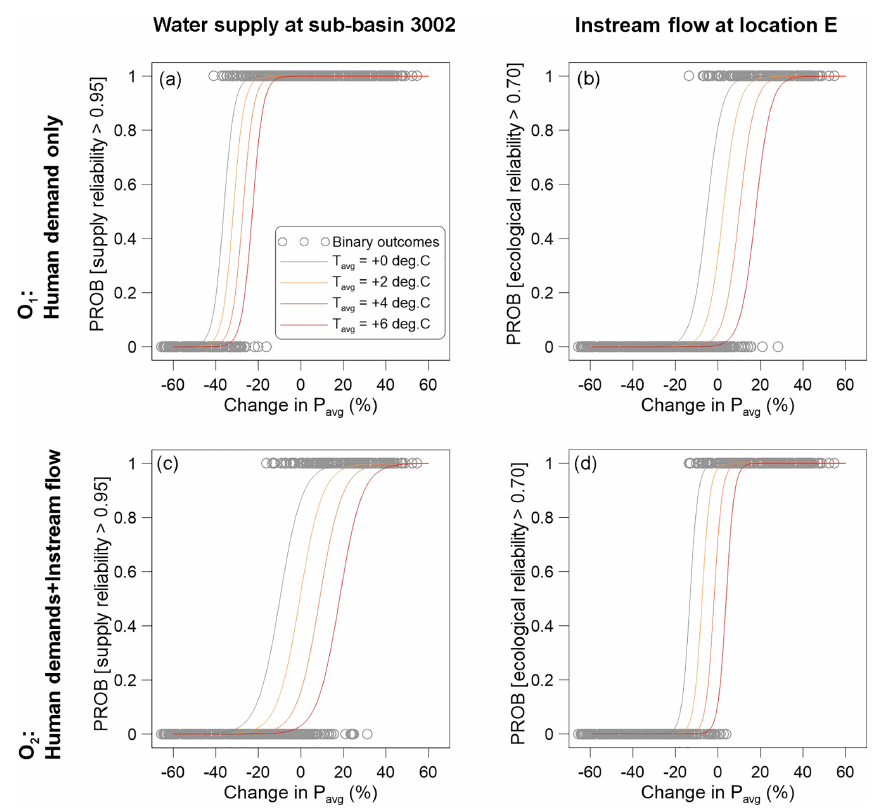
Figure 7. The logistic regression models for π s95 at the sub-basin 3002 (a, c) and π e70 at the location E (b, d) under the human-demand-only operation (a, b) , and the operation considering human demands and instream flow together (c, d)